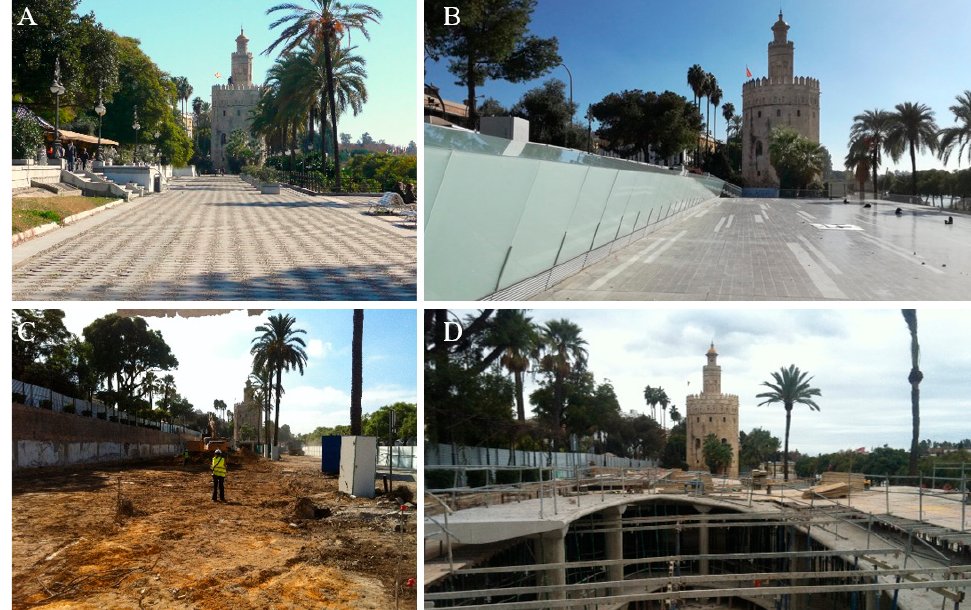
Figure 3. Photographs of the case of study: ( A ) Torre del Oro in 2014, ( B ) Torre del Oro in 2020, and ( C ) Torre del Oro during works in-site in August 2015 and ( D ) February 2016. Sources: Images by authors.